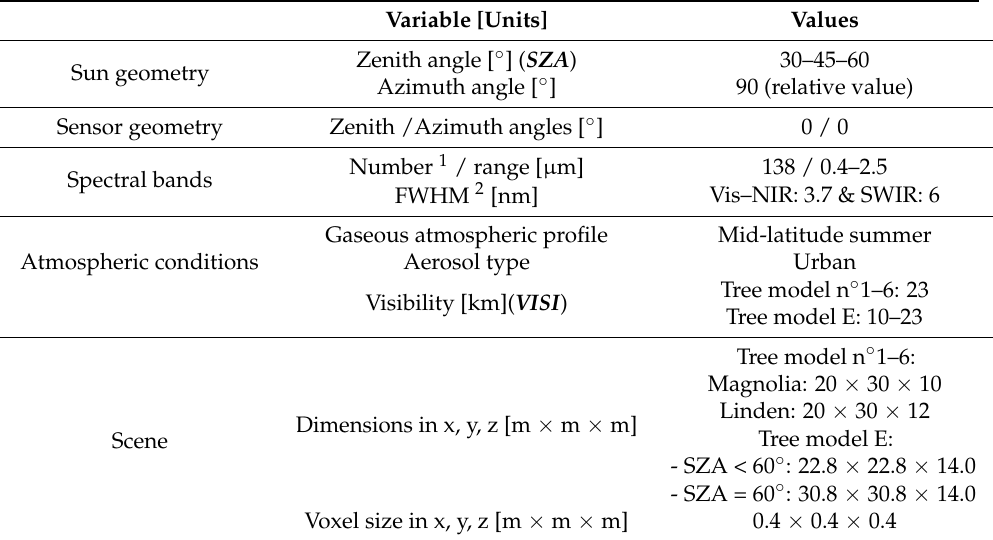
Figure 4. Optical properties of the DART scene background (reflectance, and both the trunk (re- flectance) and leaves (reflectance and 1 − transmittance) for the empirical tree model E. Differences in the number of displayed dots are due to the fact that the spectra do not have the same num- ber of wavelengths. DART applies an interpolation for wavelengths where the spectrum value is not provided. Table 3. DART geometric configuration of the scene, sun direction, atmosphere, and sensor (the acronyms of the variable parameters are highlighted in italics and